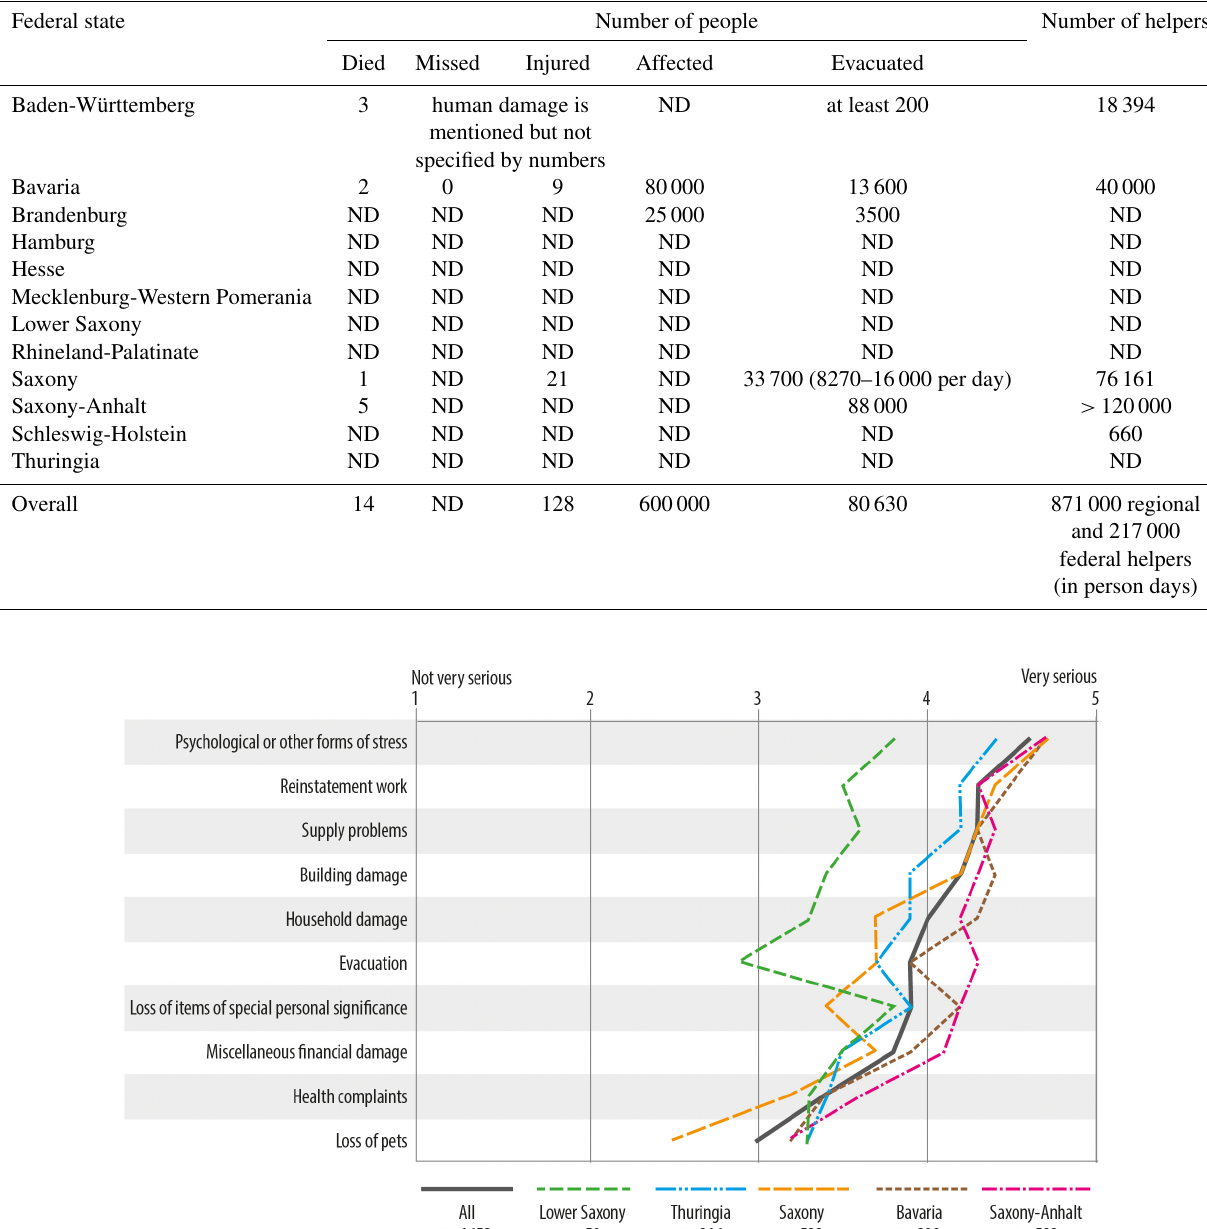
Table 1. Overview of human loss indicators as recommended by Corbane et al. (2015) or IRDR (2015), accessible for the flood in June 2013